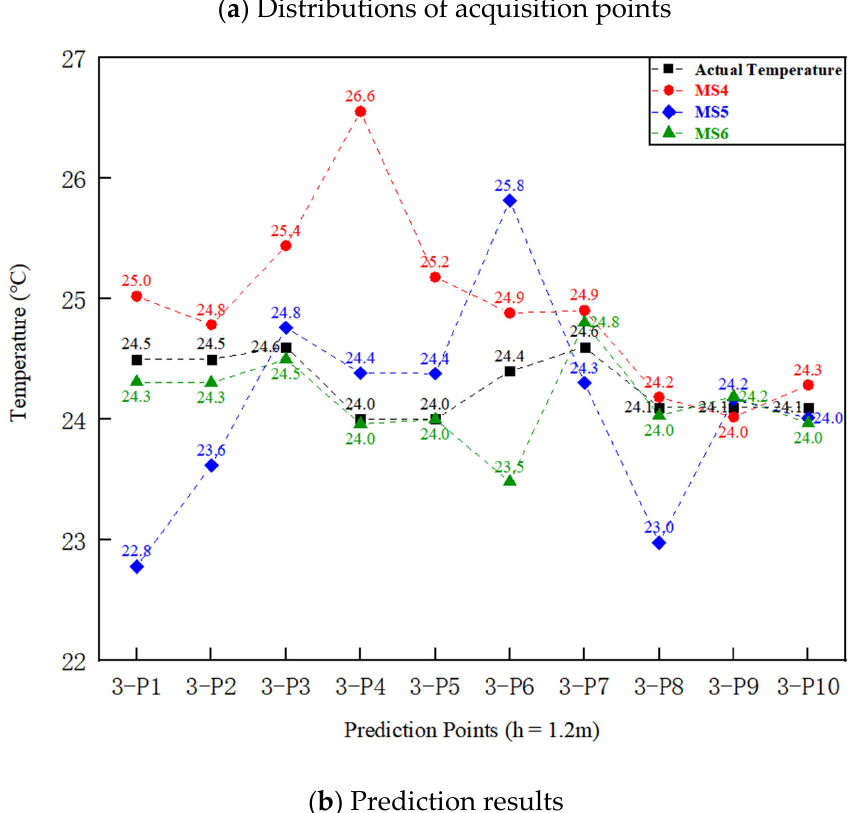
Figure 12. Prediction of mobile sensors with acquisition distance of 2.0 m.